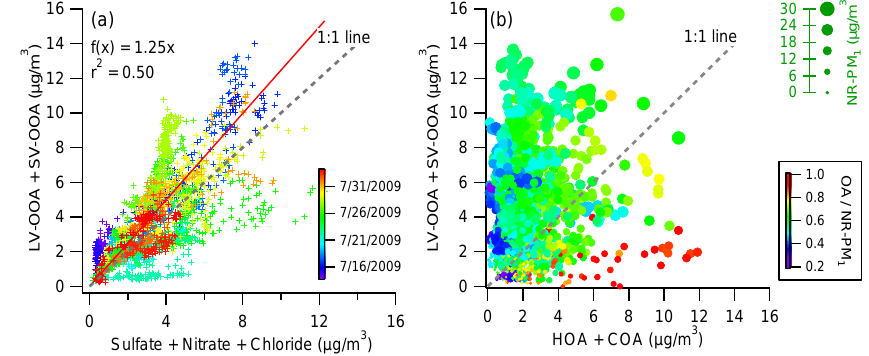
Fig. 12. Correlations of (a) total OOA (=LV-OOA+SV-OOA) vs. total secondary inorganic anions (=Sulfate+Nitrate+Chloride). The data fitting was performed using the orthogonal distance regression (ODR), and (b) total OOA vs. POA (=HOA+COA), colored by the mass fraction of OA in NR-PM 1 . The marker size is proportional to the concentration of total NR-PM 1 .